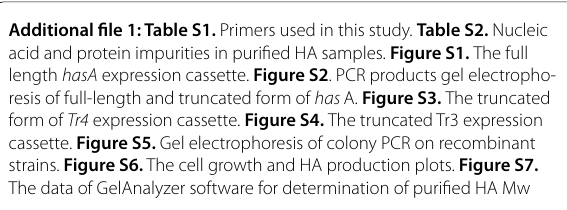
strains. Figure S6. The cell growth and HA production plots. Figure S7. The data of GelAnalyzer software for determination of purified HA